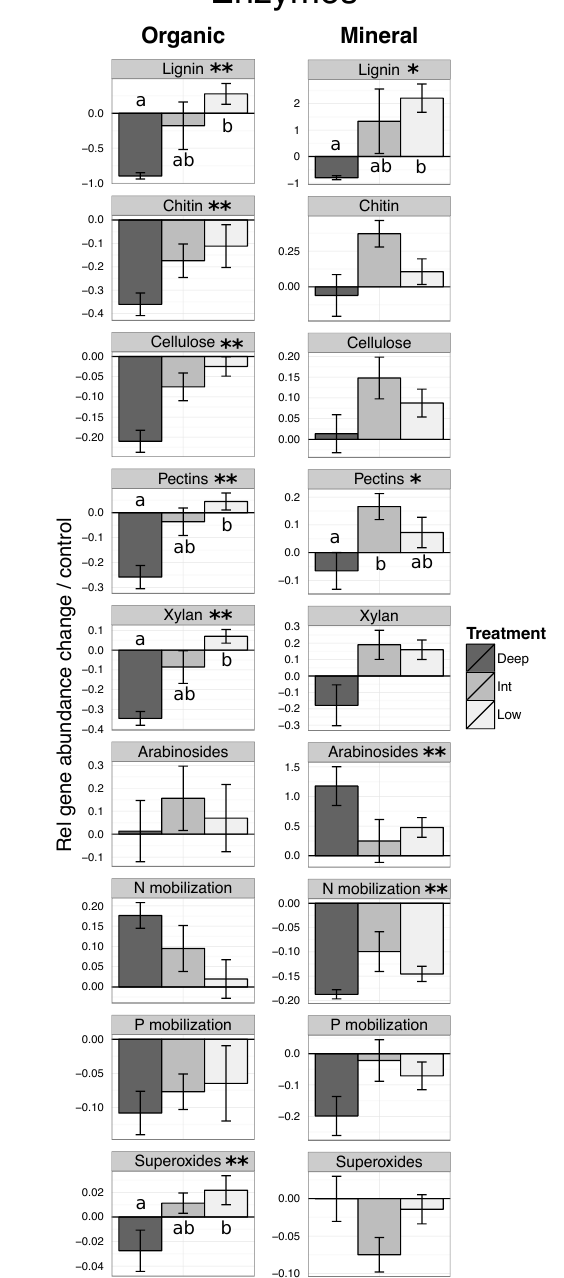
Figure 4. Averaged relative abundance of genes for enzyme func- tional groups relative to the control and separated by snow accumu- lation treatment. Functional groups involved in soil organic matter decomposition are ordered from recalcitrant to labile substrates (top to bottom). Error bars represent standard error (standard error of controls ranged from 1.220 in the lignin group to 0.008 in the super- oxides group). Significance determined by Kruskal–Wallis tests is indicated by asterisks ( ∗ = p < 0.1, ∗∗ = p < 0.05), while post hoc Nemenyi test results are indicated by “a”, “b”, or “ab”, except where there were significant differences to the